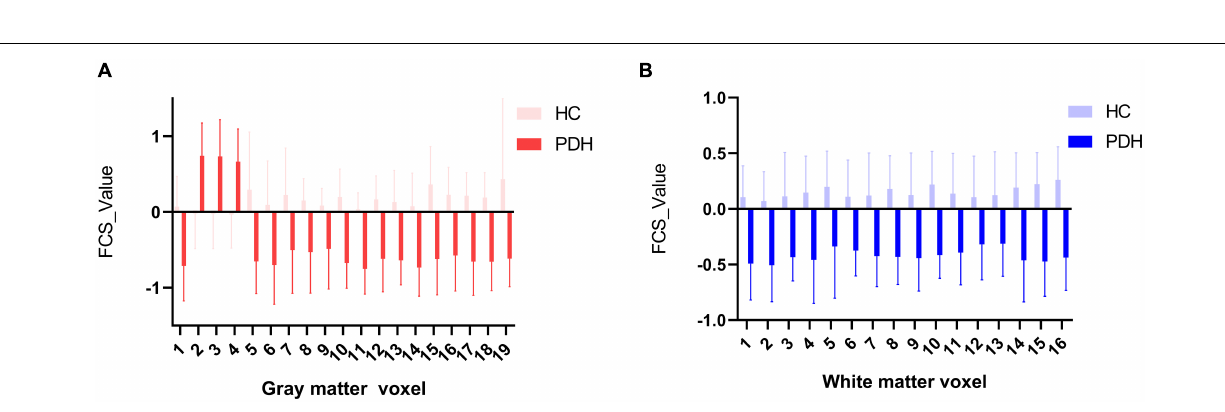
FIGURE 5 | (A) Comparison of HC and PDH in average FCS of gray matter voxels; (B) comparison of HC and PDH in average FCS of white matter voxels.